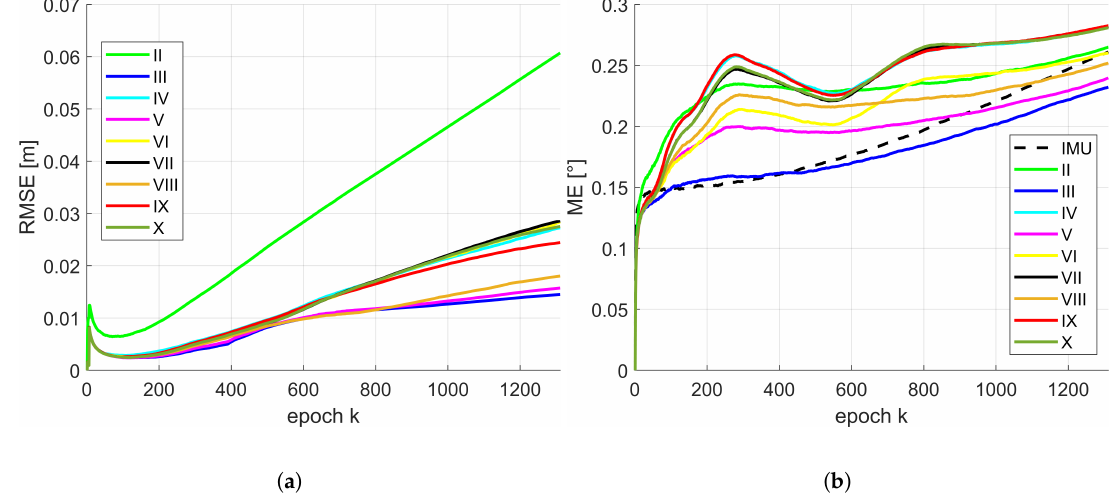
Figure 8. Accurate IMU: temporal progress of the median of the RMSE for position ( a ) and ME for orientation ( b ) by means of 500 replications for respective combinations of the state constraints applied. The Roman numerals refer to respective state constraints applied regarding Table 3.